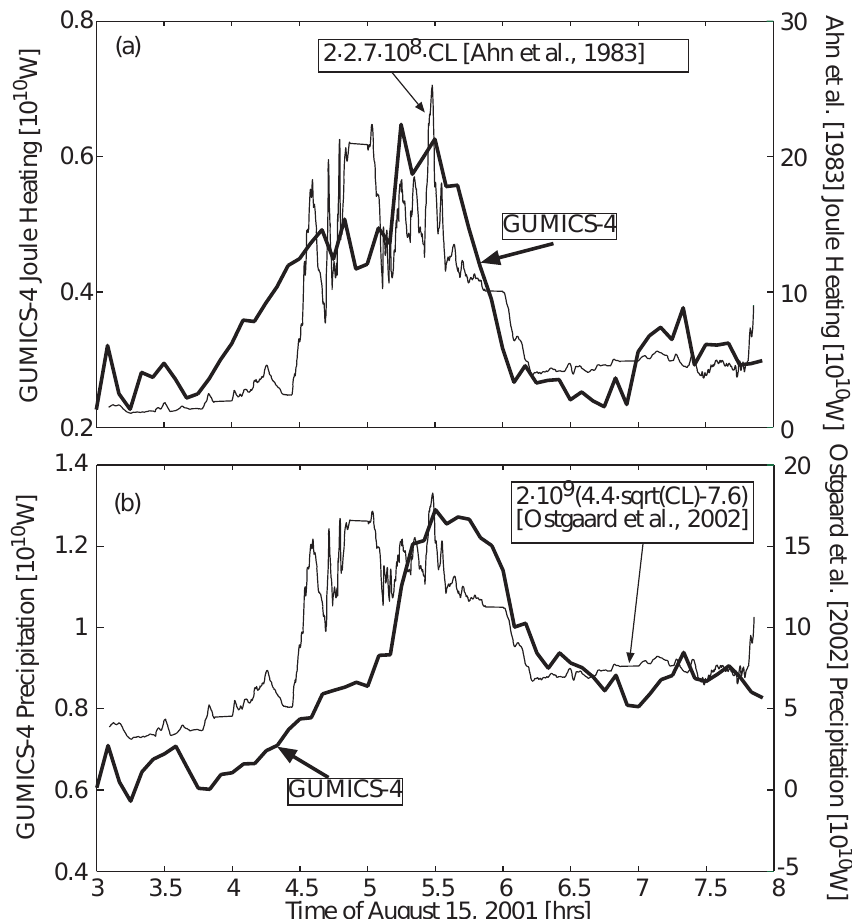
Fig. 6. (a) Joule heating power and (b) precipitation power in the ionosphere during the 15 August 2001 substorm as described by the GUMICS-4 global MHD simulation (thick line). The thin lines are calculated using equations presented in Ahn et al. (1983) and Østgaard et al. (2002).